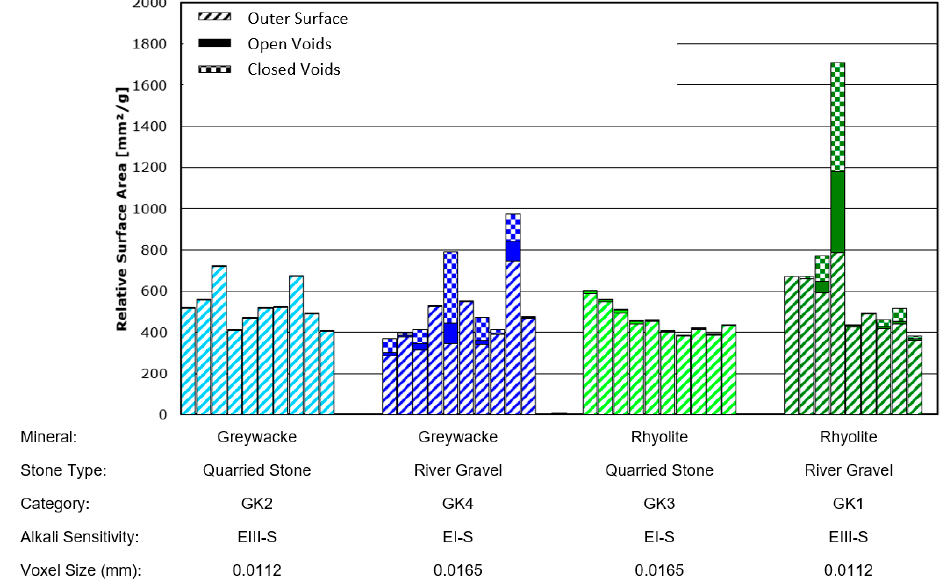
Figure 14. Surface area measurement comparison between quarried-stone (GK2 and GK3) and river-gravel (GK1 and GK4) aggregates of the same mineral types (based on figures in [10,11]).